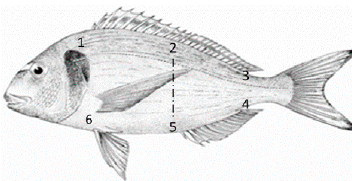
Figure 1. Scheme of the left side of a gilthead seabream specimen. Numbers represent the skin regions considered for scale extraction in the present study: 1 (operculum), 2 (dorsal), 3 (upper-peduncle), 4 (low-peduncle), 5 (anal), 6 (pectoral).